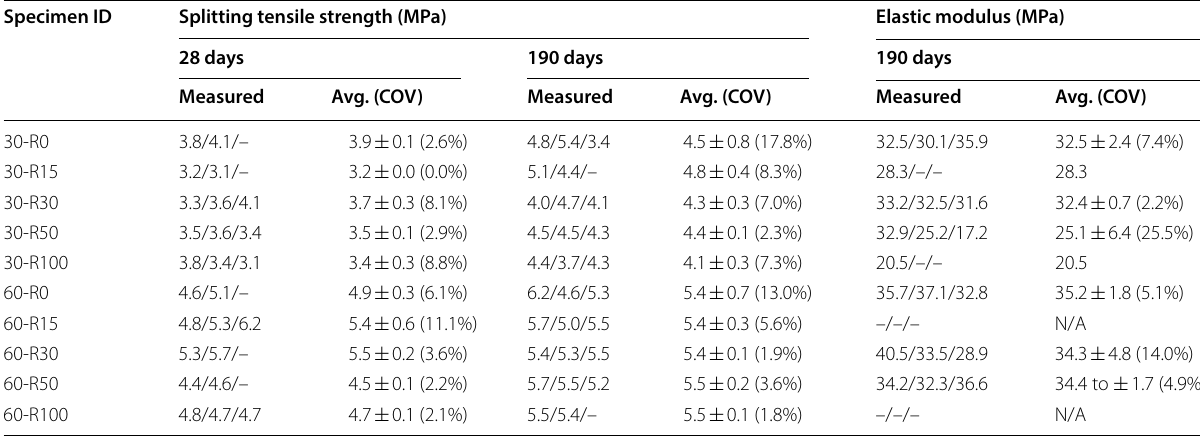
Table 7 Measured splitting tensile strength and elastic modulus. Specimen ID